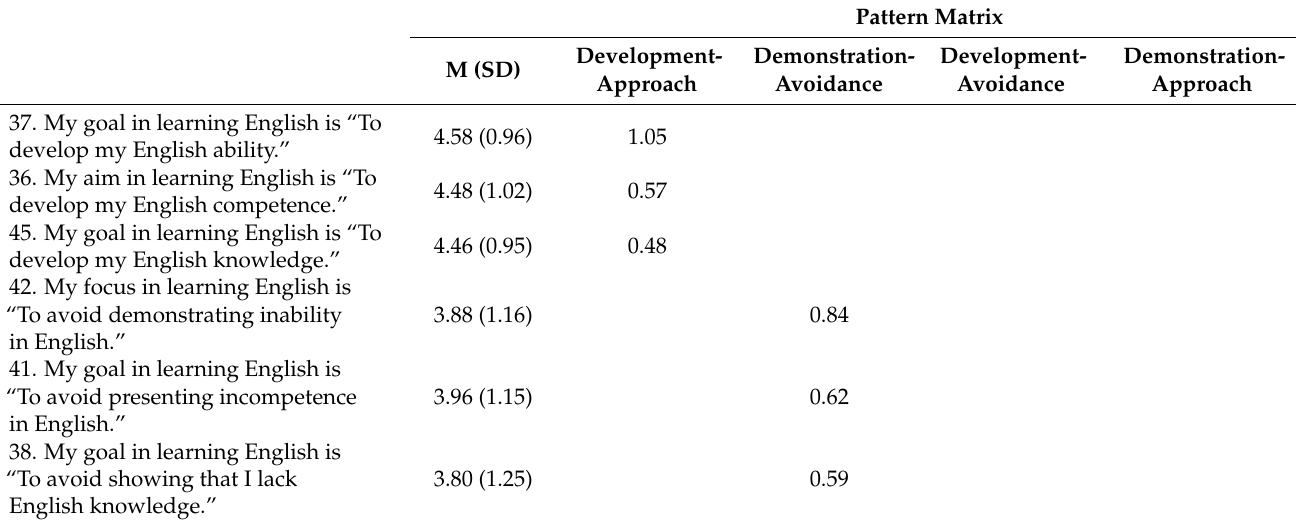
Table A2. Exploratory Factor Analysis of Achievement Goals with Factor Loadings ≥ 0.30